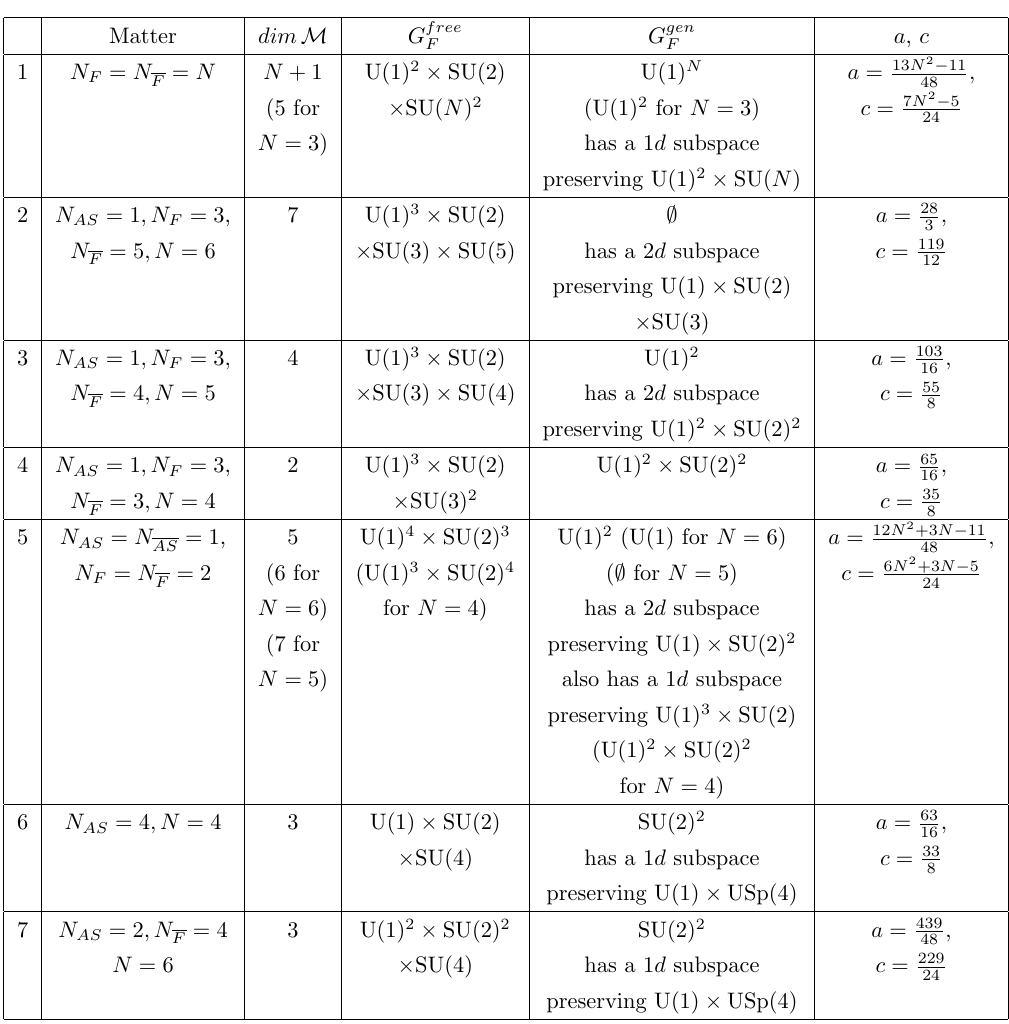
Table 2 . Cases involving an SU( N ) gauge group with two adjoint chiral (cid:12)elds. Note that the two adjoint chiral (cid:12)elds are not written in the